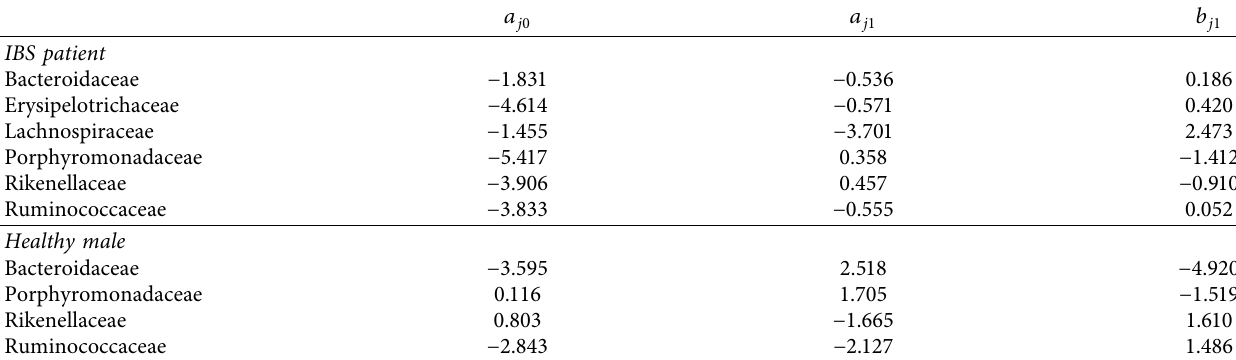
Figure 3: Model fitting each family in the IBS patient. Relative abundances reported are represented by solid points. The solid line shows the estimated values. Standard deviation interval has also been plotted with dashed lines, E ( y it ) ± 2 · (b) Erysipelotrichaceae. (c) Lachnospiraceae. (d) Porphyromonadaceae. (e) Rikenellaceae. (f) Ruminococcaceae. (g) Table 1: Estimated parameter values for IBS patient (top) and healthy male (bottom).